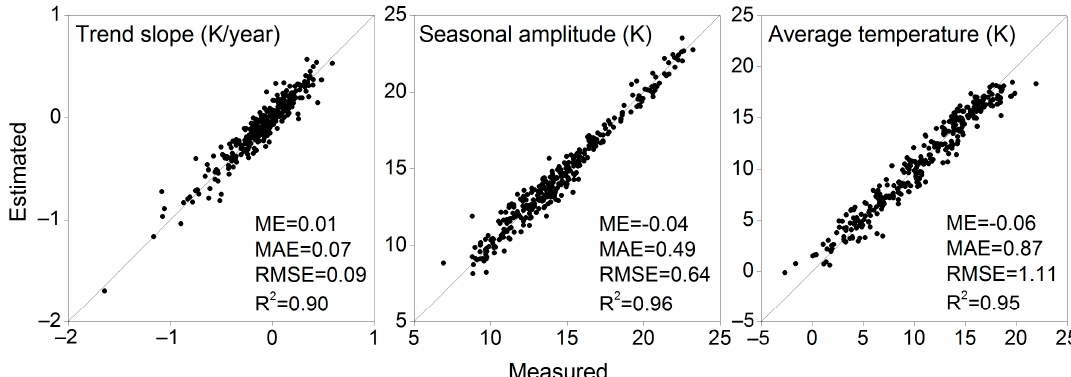
Figure 10. Scatter plots of the trend slope, seasonal amplitude, and annual average temperature respectively, derived from the measured and the estimated Ta over the collocated weather stations.